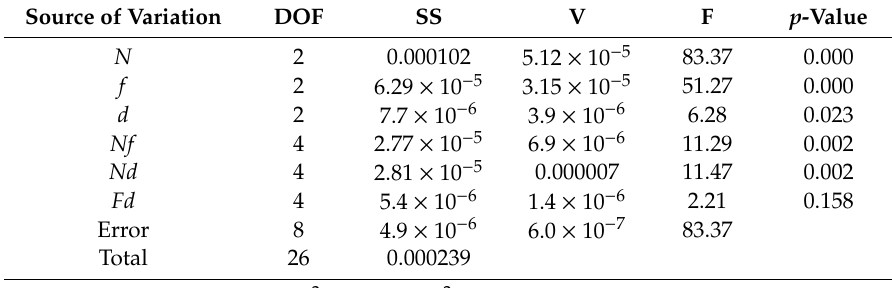
Table 7. ANOVA results for TWR.